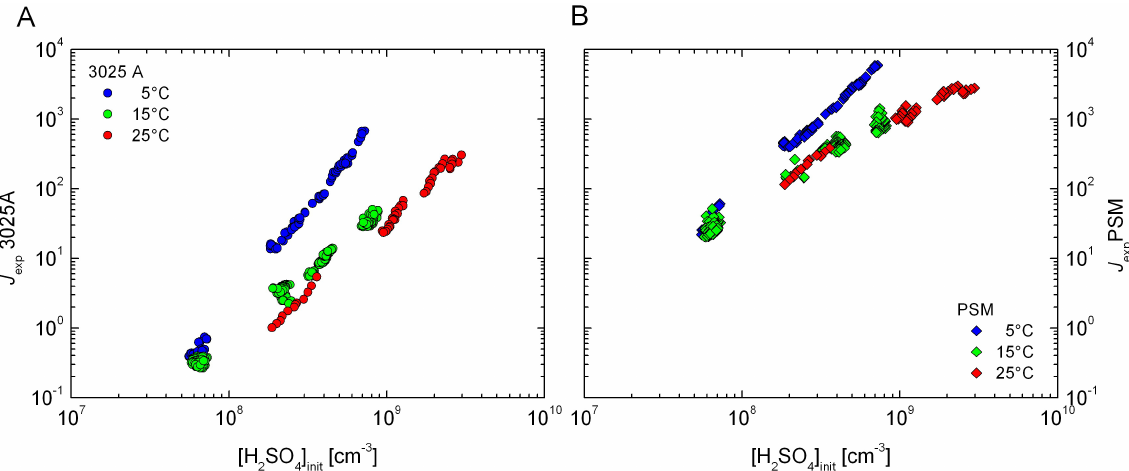
Fig. 2. Nucleation rate (cm − 3 s − 1 ) as a function of sulfuric acid initial concentration at three different nucleation temperatures (5, 15 and 25 ◦ C). Particle number concentration measured with UCPC TSI 3025A (A) and particle size magnifier (PSM) (B) .